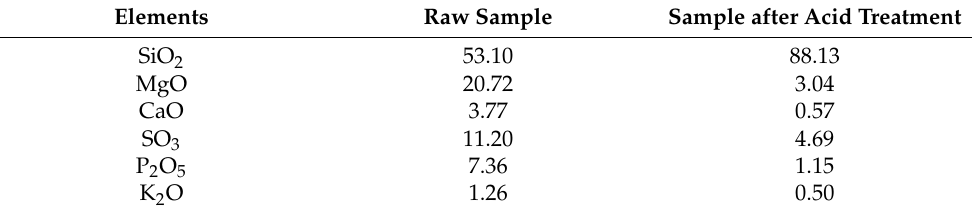
Table 2. Elemental composition of sugarcane bagasse ash